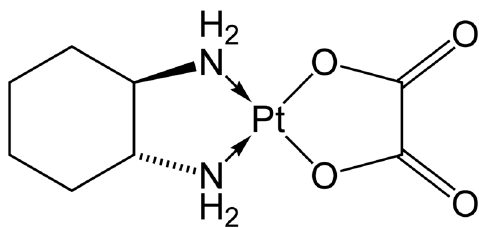
Figure 2. Structure of oxaliplatin.